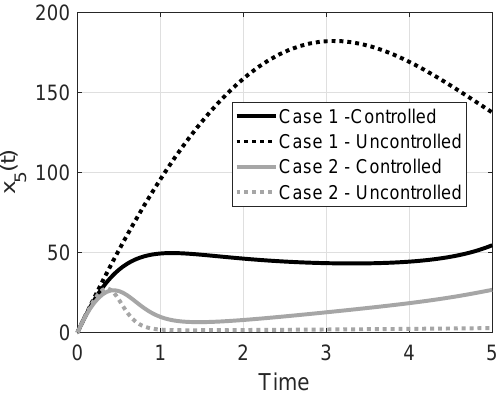
Figure 9. Evolution of the number of x 5 ( t ) subjects in Case 1 (black line) and Case 2 (grey line) with (continuous line) and without control (dotted